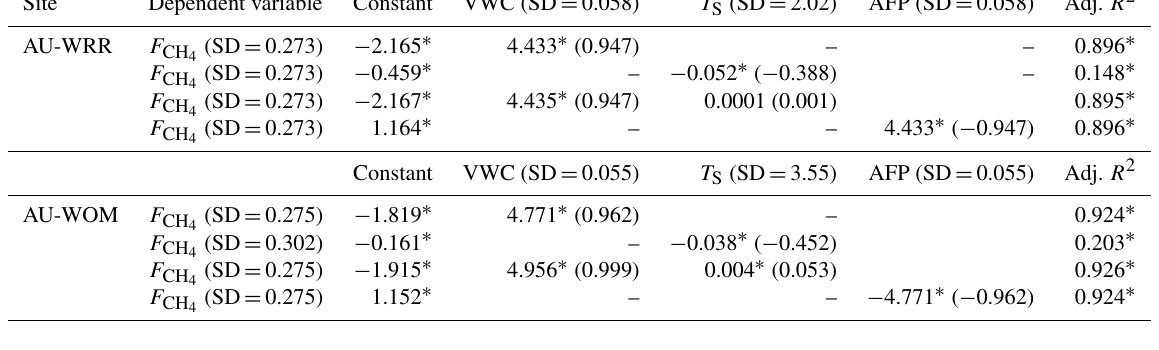
Table 3. Parameters and coefficients of determination (Adj. R 2 ) of linear regression models explaining seasonal variability in mean daily ) at a mixed Eucalyptus obliqua forest stand, Wombat State Forest, Victoria (AU-WOM) and at a mixed E. obliqua methane flux ( F CH 4 and E. regnans forest stand, Warra LTER, Tasmania, Australia (AU-WRR). Standardised coefficients β are in parentheses; SD refers to standard deviation of parameter; level of significance ( ∗ ≤ 0 . 001). Predictors: T S (soil temperature), AFP (air-filled porosity) and soil VWC (volumetric water content). Presented constants are model intercepts and parameters represent the slopes for the predictor variables.